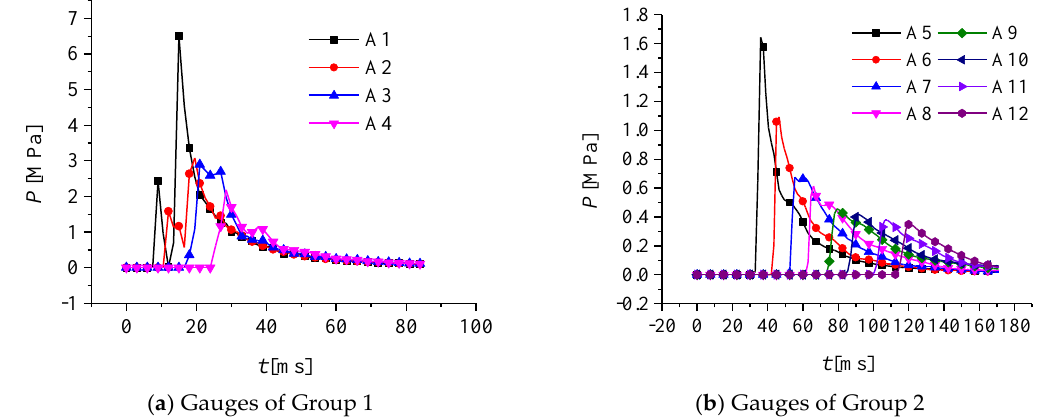
Figure 8. Pressure-time curves at 2 m gauges of shockwave above the rigid ground.